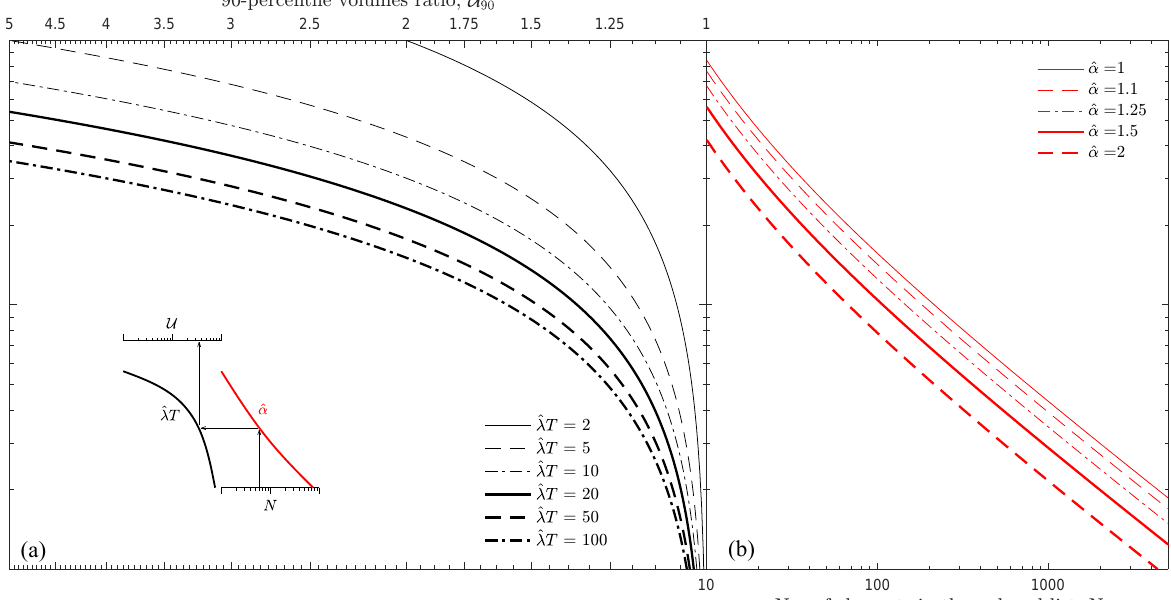
Figure 5. Design graph for the estimation of the volume multiplier (90 percentile) accounting for the number N of measured blocks in the reduced list, F ∗ , and the term ˆ λT , and Pareto type I distribution shape parameter, ˆ α .